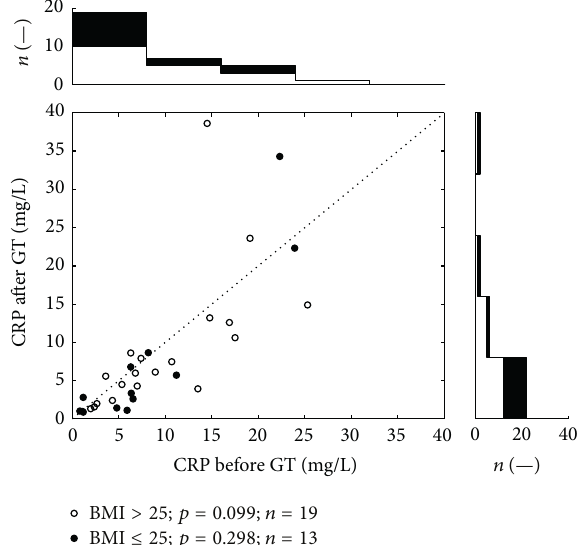
Figure 4: The variation in CRP values, BMI separation. The scatter plot depicts serum CRP levels before and after GT in a similar way as in Figure 1. This plot divides the group of patients by BMI value. Patients with BMI over 25 are plotted as open circles and patients with BMI below or equal to 25 are represented as black dots. All together 32 dots represent 64 measurements; each dot belongs to one patient. The top histogram shows data distribution before the treatment; the right side histogram corresponds to the after treatment values